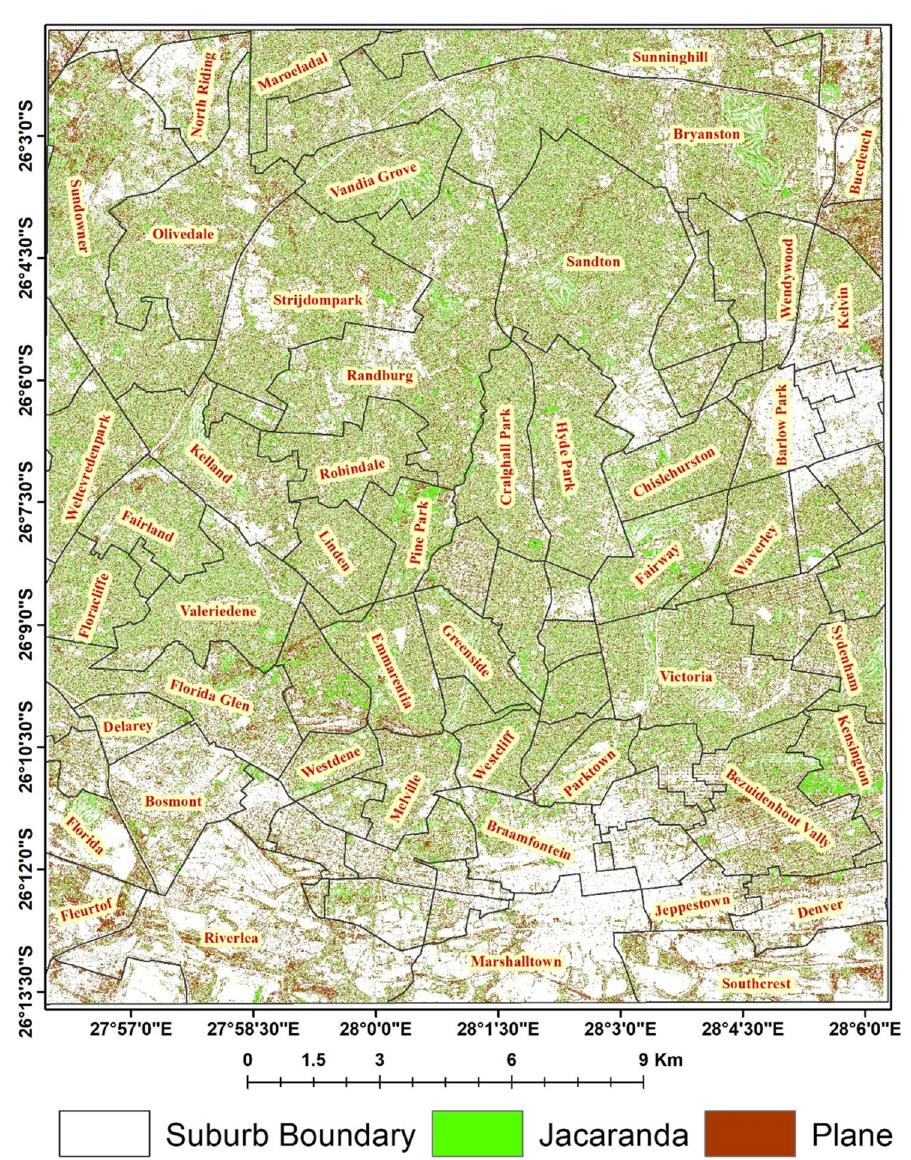
Figure 5. The distribution map of two common street trees ( Jacaranda mimosifolia and Platanus x acerifolia ) in the suburbs of Johannesburg City, South Africa classified using SPOT 6 data obtained from the South African National Space Agency